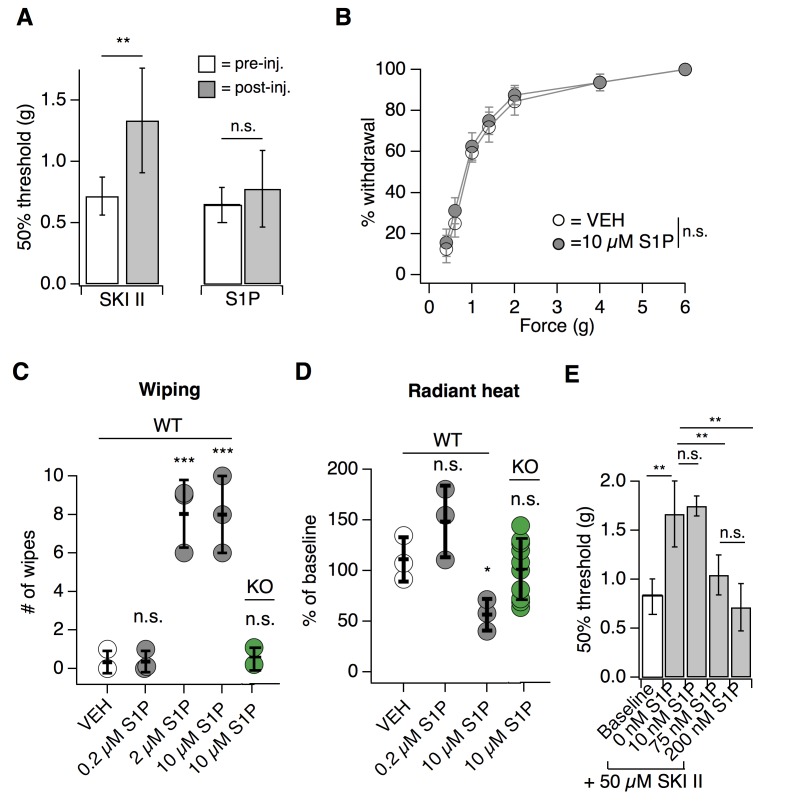
Endogenous S1P mediates acute mechanical pain.(A) von Frey 50% withdrawal measurements for mice pre- and post-injection of 50 µM SKI II (N = 8) or 10 µM S1P (N = 7); p=0.003, 0.604 (two-tailed paired t-tests). (B) von Frey force-response graph for animals injected with 10 µM S1P or 0.1% MeOH-PBS; pgenotype >0.05 (two-way ANOVA; N = 8 mice per group). No Tukey HSD comparisons at any force between genotypes were significant. (C) Intradermal cheek injection of 10 µM S1P, 2 µM, 0.2 µM, and 20 µL 0.3% methanol PBS (vehicle), with quantification of number of forepaw wipes over the 5 min post-injection interval; p<0.0001 (one-way ANOVA; N = 3 mice per condition). Dunnett’s multiple comparisons p-values are represented on graph for comparisons made between treated and vehicle groups. (D) Radiant heat normalized paw withdrawal latencies 20–30 min post injection of 15 µL 10 µM S1P, 0.2 µM S1P. or 0.3% methanol-PBS vehicle (i.d.) into the hind paw of S1PR3 WT or KO mice; p=0.0129 (one-way ANOVA; N = 3–10 mice per condition). Dunnett’s multiple comparisons p-values are represented on graph for comparisons made between treated and vehicle groups. (E) von Frey 50% withdrawal measurements for mice pre- (baseline) and post-injection of 50 µM SKI II (N = 14) and 0 (N = 4), 10 (N = 3), 75 (N = 4), or 200 nM S1P (N = 3; one-way ANOVA; p=0.0001). Tukey Kramer comparisons are indicated on graph. Error bars represent mean ± SD.10.7554/eLife.33285.006Figure 2—source data 1.Endogenous S1P mediates acute mechanical pain.Related to Figure 2.